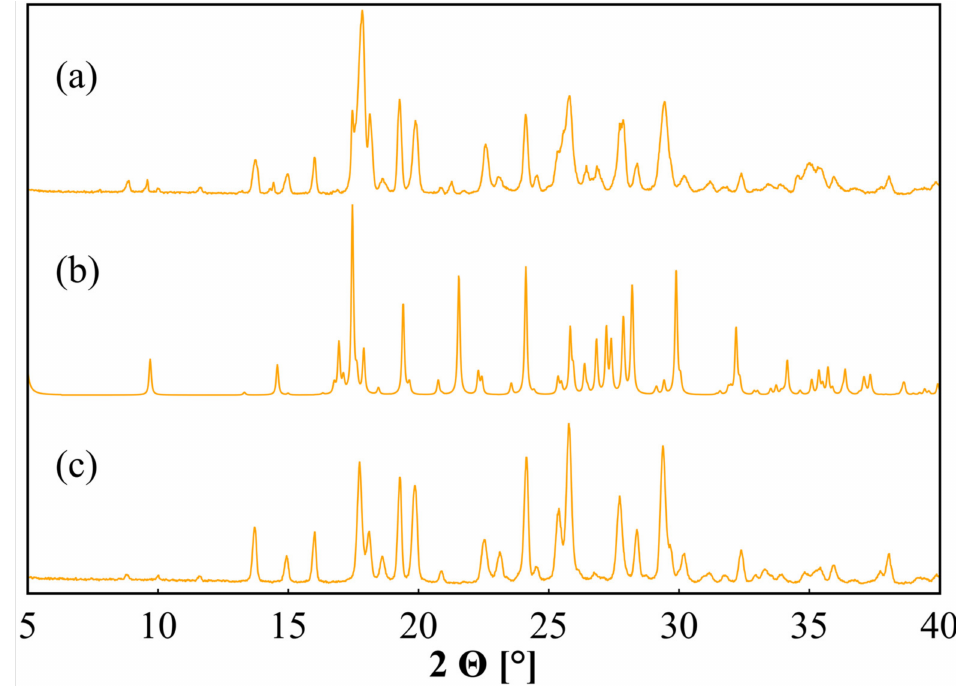
Figure 8. Powder patterns of 4 -based maleates. Sample of 4-MA obtained by solution crystalliza- tion ( a ), simulated pattern based on single crystal data ( b ), and a sample of 4-MA obtained by mechanochemical crystal synthesis ( c ). Powder patterns were recorded in a range of 5 ◦ –40 ◦ 2 Θ .